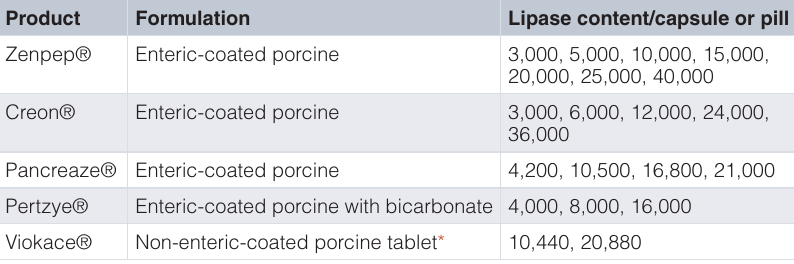
Table 1. Enzyme therapy for exocrine